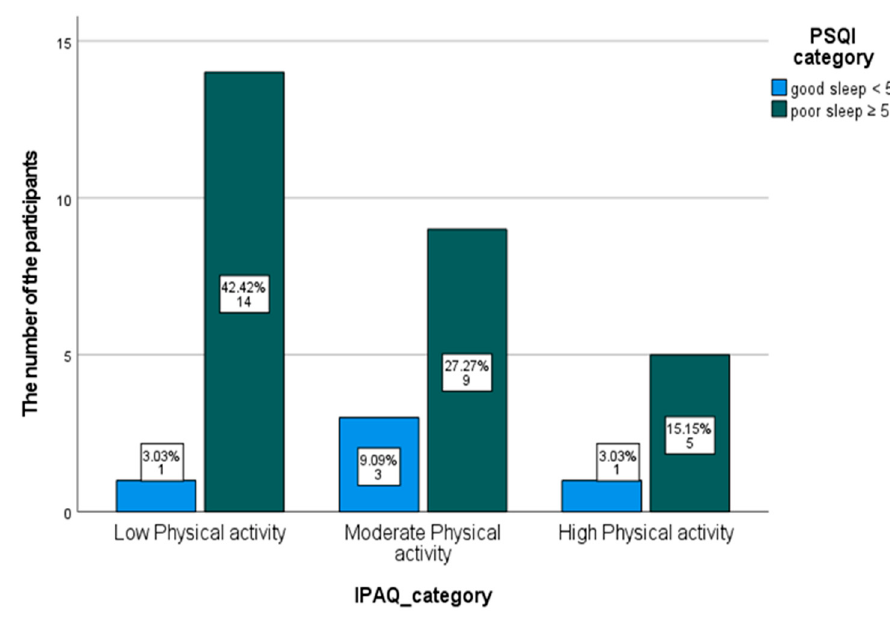
Figure 2. A bar chart of the number and frequency of IPAQ categories and PSQI categories.